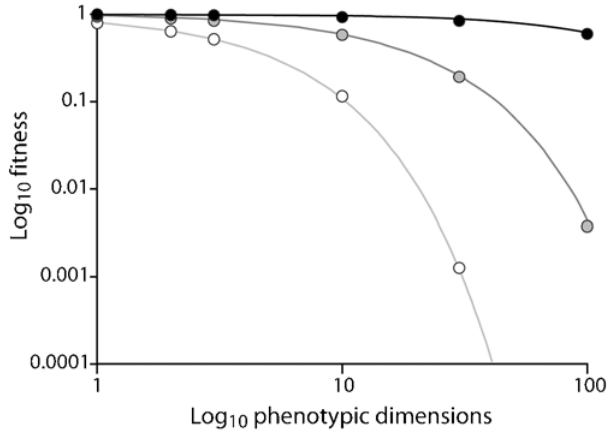
Figure 2. Predicted equilibrium fitness as a function of phenotypic complexity (n e ) . Results are shown for populations of size 100 (black), ten (grey), and three (white). An exponential fitness decline in which Q=1 was used (yielding a fitness function of f(d)=exp( 2 d)). Circles indicate the average fitness reached in the simulation model; curves indicate the analytical